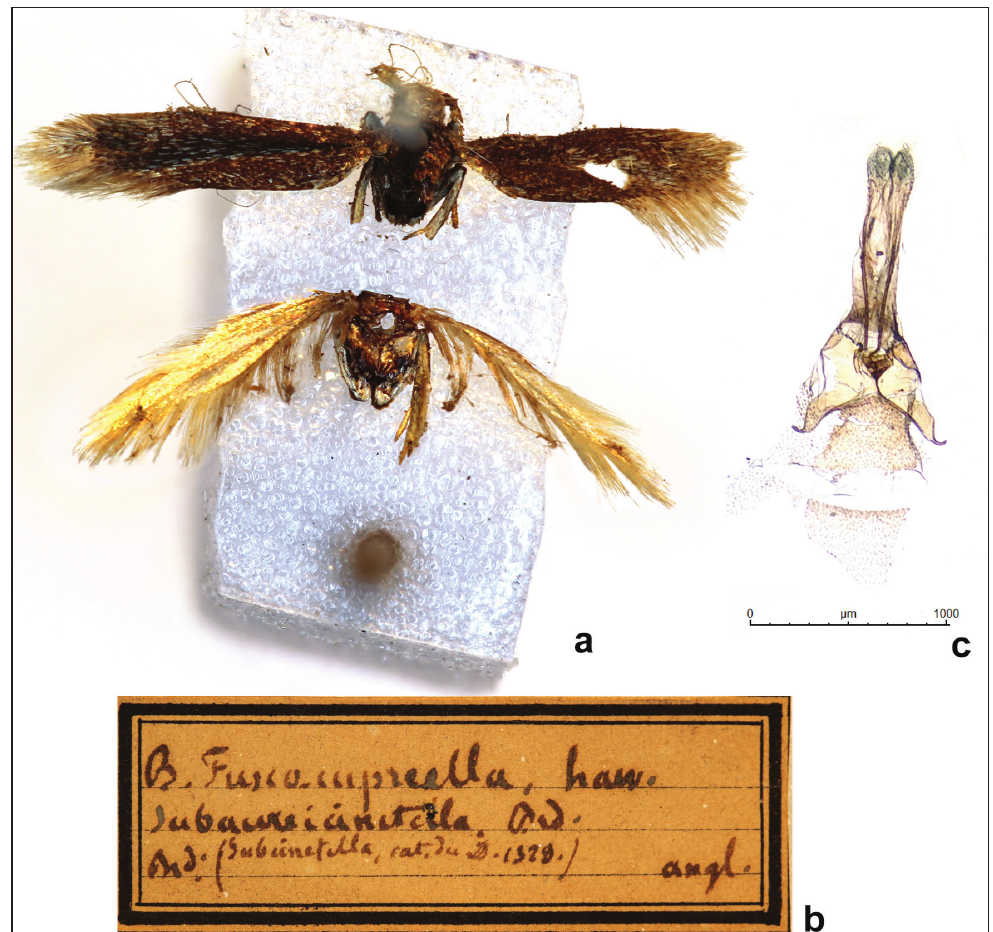
Figure 6. Scythris picaepennis (Haworth, 1828) (identified by Bruand as Butalis fuscocuprella Haworth, 1828), female. a – habitus, wingspan 11 mm; b – original label; c –